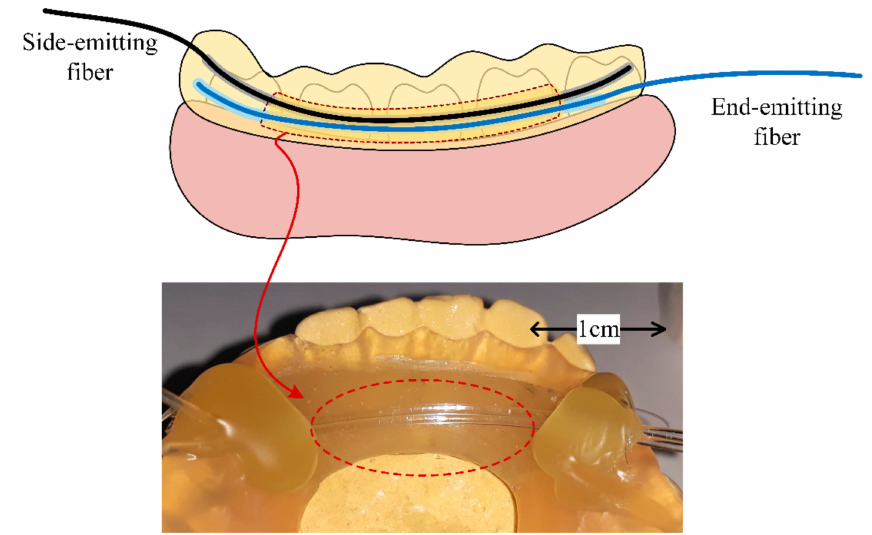
Figure 5. Practical realization of the extended sensing area intra-oral sensor laboratory proof of concept, which has the side emitting fiber and the end-emitting fiber deployed in parallel and integrated into a frontal mouthguard. The source, which feeds light axially into the side-emitting fiber, is external to the